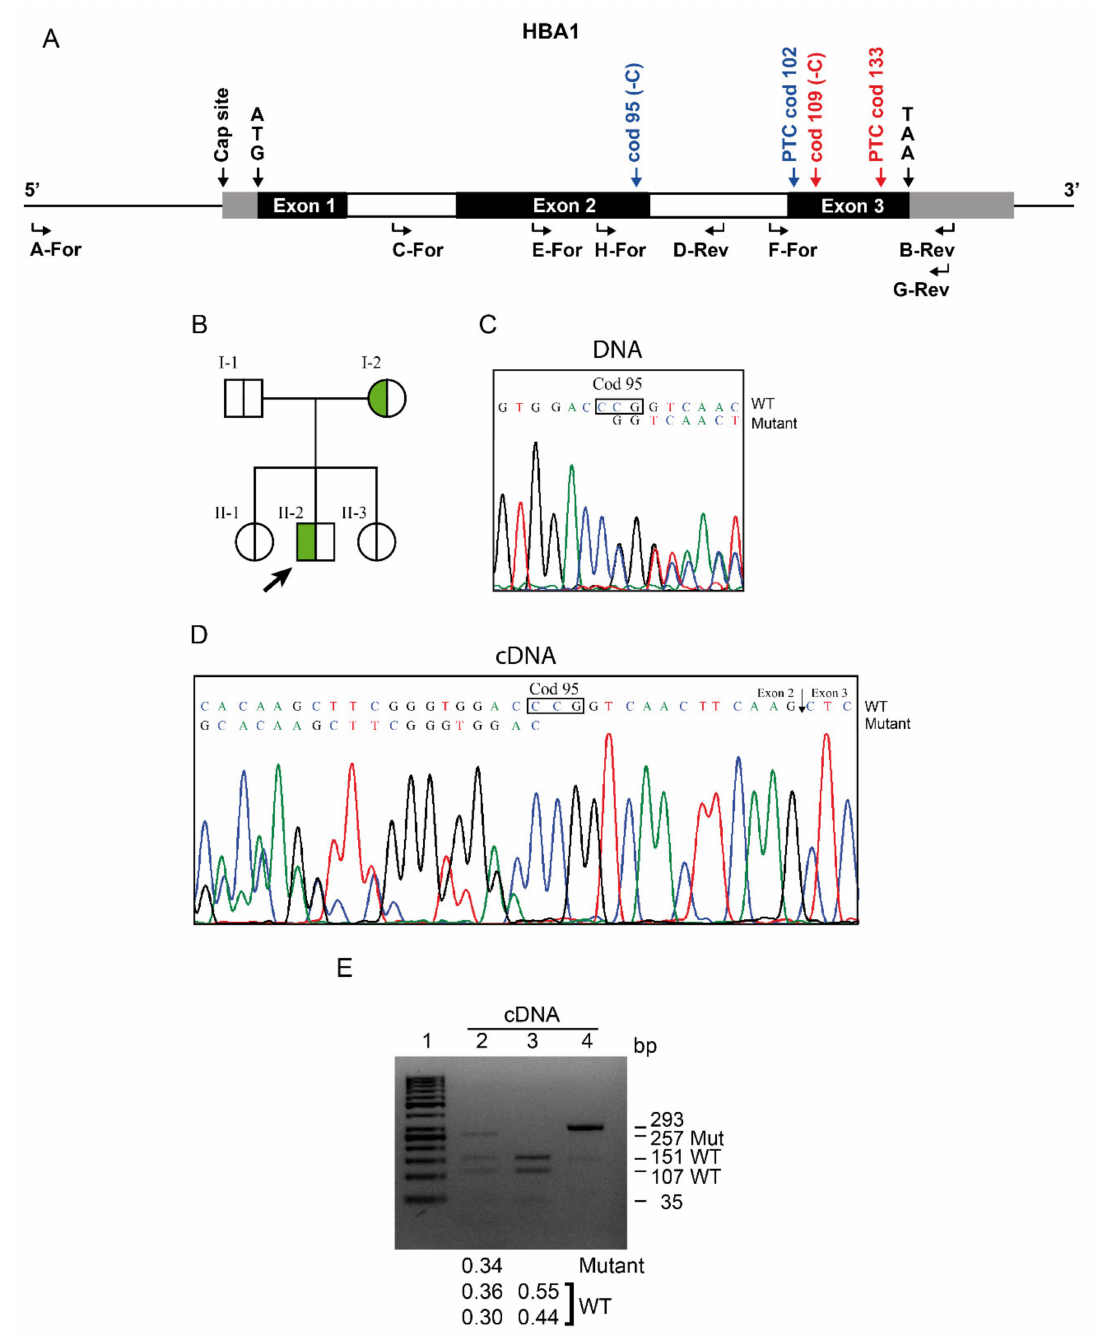
Figure 1. Molecular characterization and cDNA analysis of Hb Campania . ( A ) Scheme of the functional structure of the α 1-globin gene (HBA1), indicating the position of cod95 ( − C) and cod109 ( − C) with their relative premature termination codon (PTC). The gray rectangles indicate the 5 (cid:48) and 3 (cid:48) UTR regions, the white rectangles the introns. The positions and orientations of the primers used for the molecular characterization are indicated with arrows placed under the gene. ( B ) Pedigree of the family. The arrow indicates the proband; green indicates the carriers of Hb Campania . ( C , D ) α 1-globin gDNA ( C ) and cDNA ( D ) sequences of a carrier of Hb Campania . ( E ) The cDNA amplicomers of 293 bp, digested by the restriction enzyme NlaIV, and separated on a 3.5% NuSieve 3:1 agarose gel. Lane 1: 50 bp ladder; Lane 2: cDNA of the Hb Campania carrier; Lane 3: cDNA of the control subject; Lane 4: undigested cDNA sample. The fragments’ lengths are reported on the right. The Hb Campania eliminates the NlaIV restriction site GGA’CCC, generating an anomalous longer cDNA band of 257 bp, corresponding respectively to the sum of the two WT-specific bands of 151 and 107 bp, minus the deleted cytidine base. The relative amounts of the longer abnormal band and the WT-bands are reported in the lower